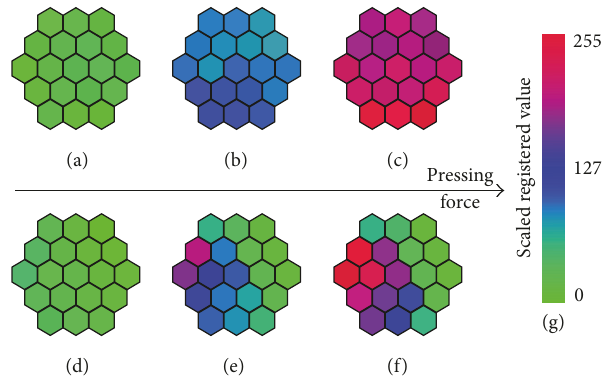
Figure 2: Visualisation of tactile frames registered during examina- tion of a homogeneous area (a–c) and a heterogeneous area (d–f). Pressing force grows from left to right. Each hexagon corresponds to 1 pressure sensor. Registered values are scaled and colour-coded using a green-blue-red colour scale presented in panel